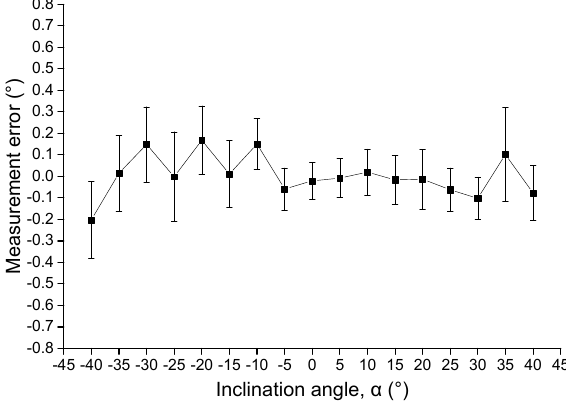
Figure 9. Accuracy test of the proposed tilt sensor with Model 2.